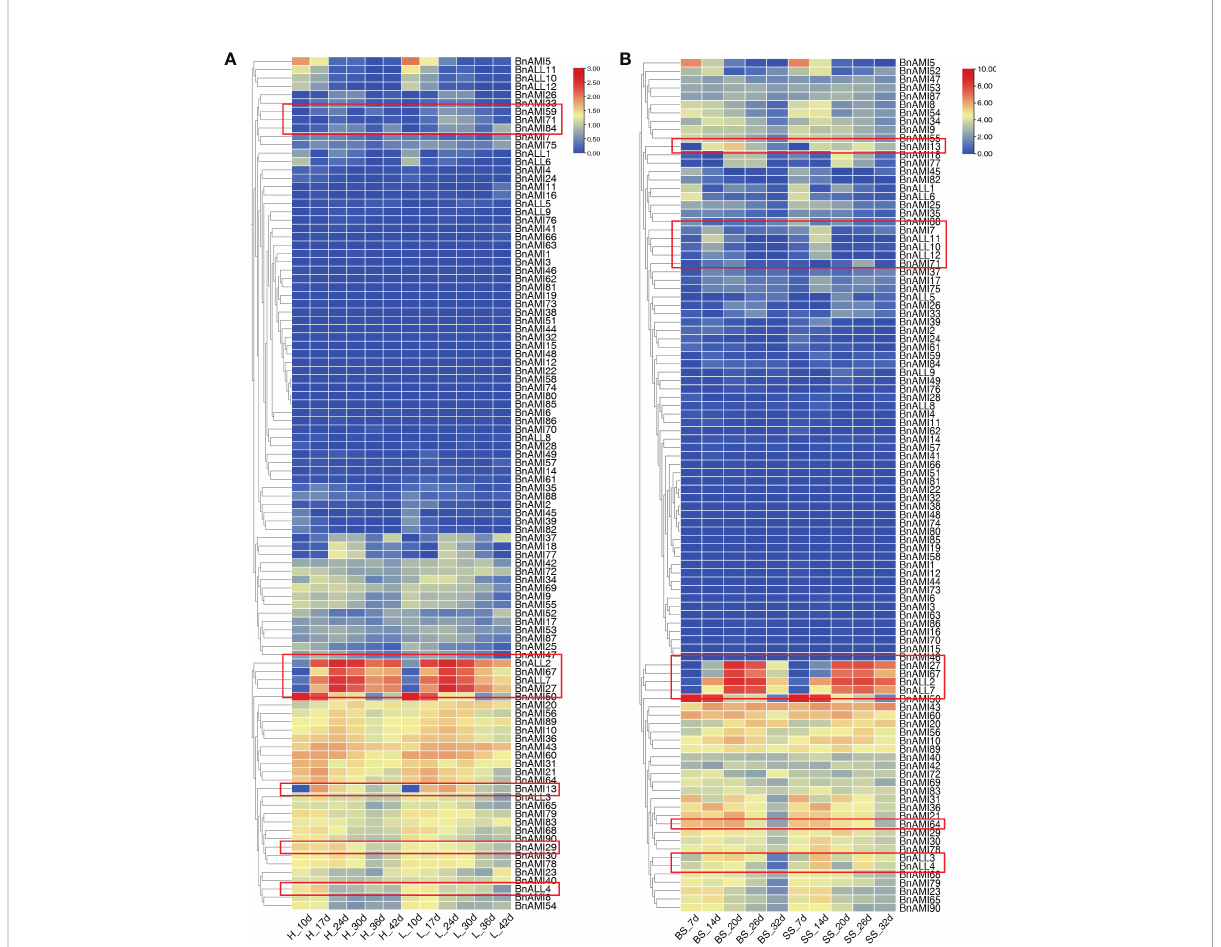
FIGURE 8 Expression of BnTAR gene in transcriptome data. The color scale represents relative expression levels with high (red) or low (blue). Red boxes indicate the genes that are differentially expressed. (A) The transcriptome data of high oil samples and low oil samples. ‘ H ’ means high oil samples while ‘ L ’ means low oil samples. (B) The transcriptome data of different seed weight simples. ‘ BS ’ means big seed simples and ‘ SS ’ means small seed simples. The letter ‘ d ’ all means how many days after fl